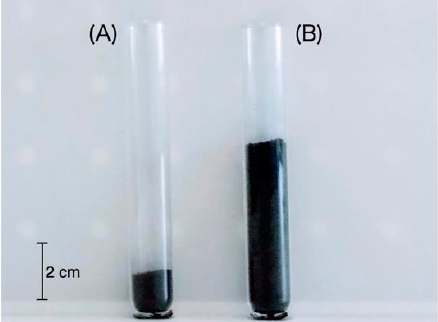
Figure 1. Photographs of unactivated adsorbent (A) and K 2 CO 3 -activated adsorbent